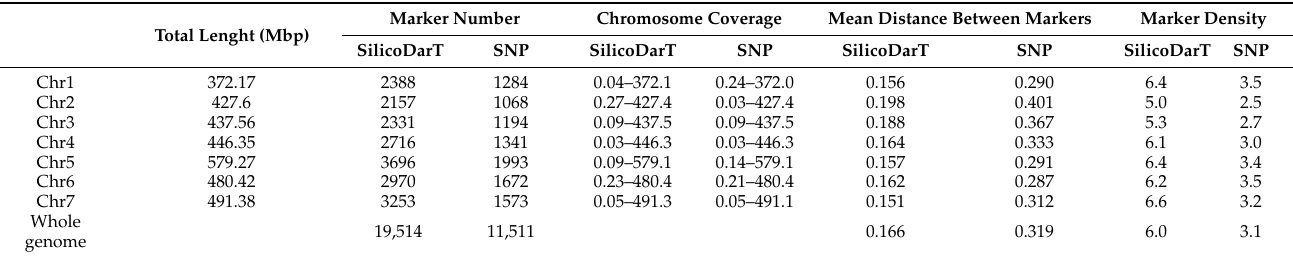
Table 3. Distribution of mapped DArTSeq markers on pea